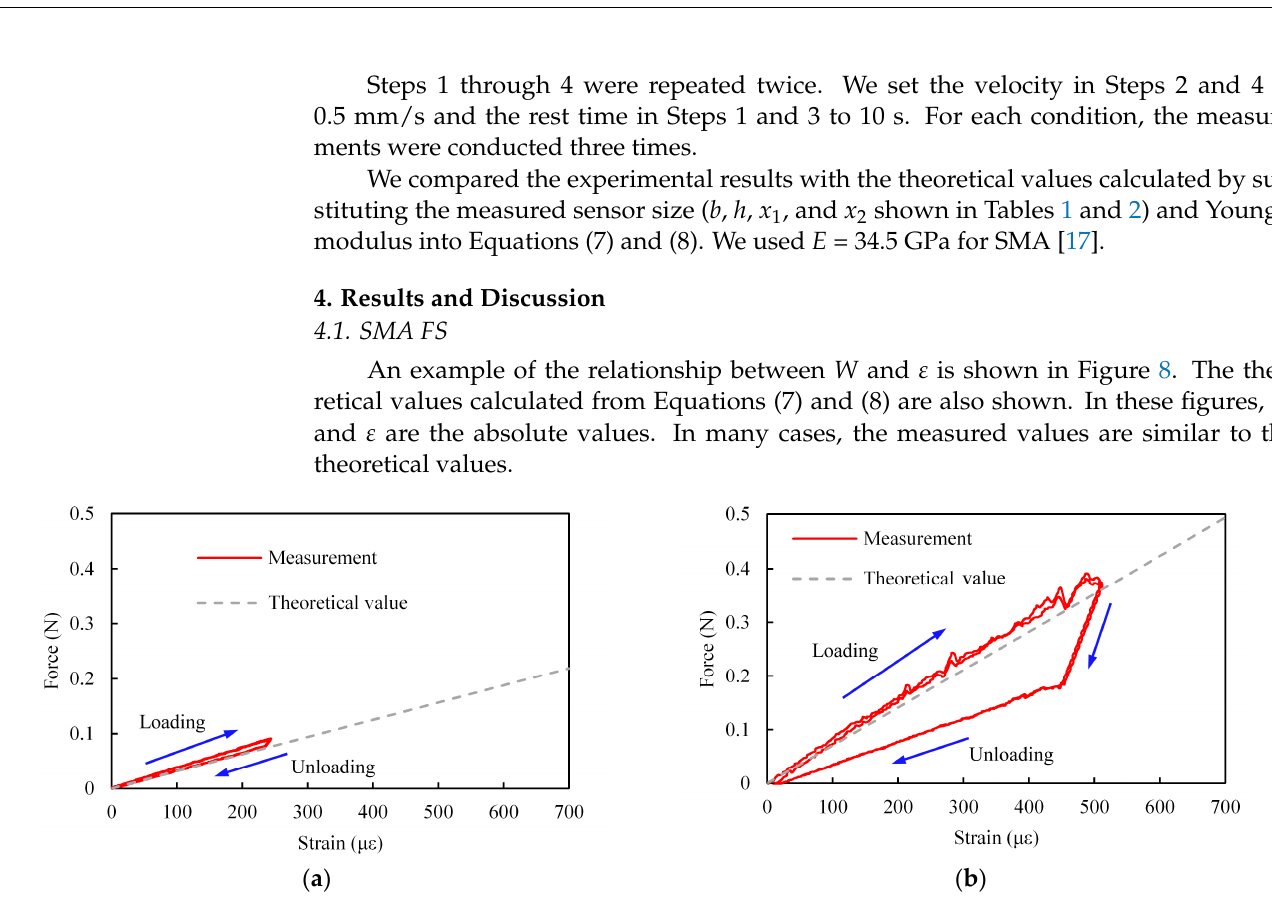
Figure 7. Appearance of ( a ) experimental apparatus (blue arrow shows sensor movement direction) and ( b ) indenters attached to load cell.